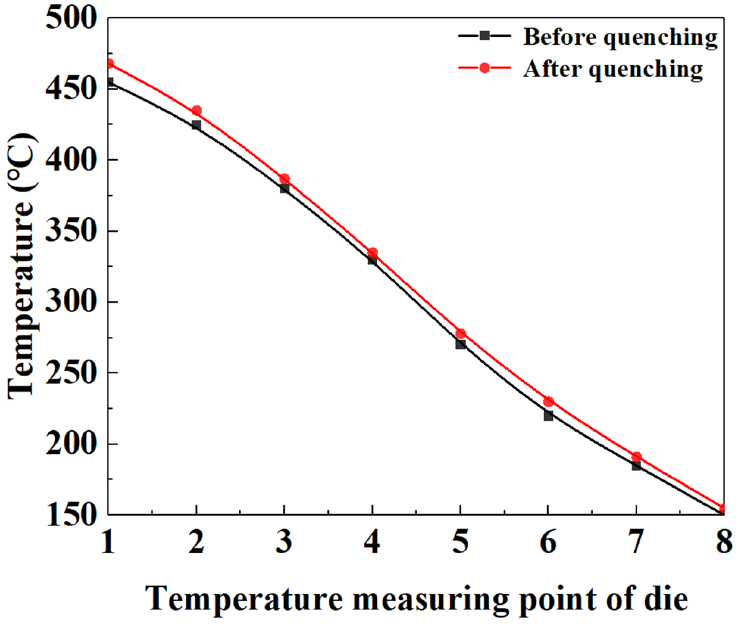
Figure 12. Temperature distribution of eight temperature measuring points of die before and after quenching.